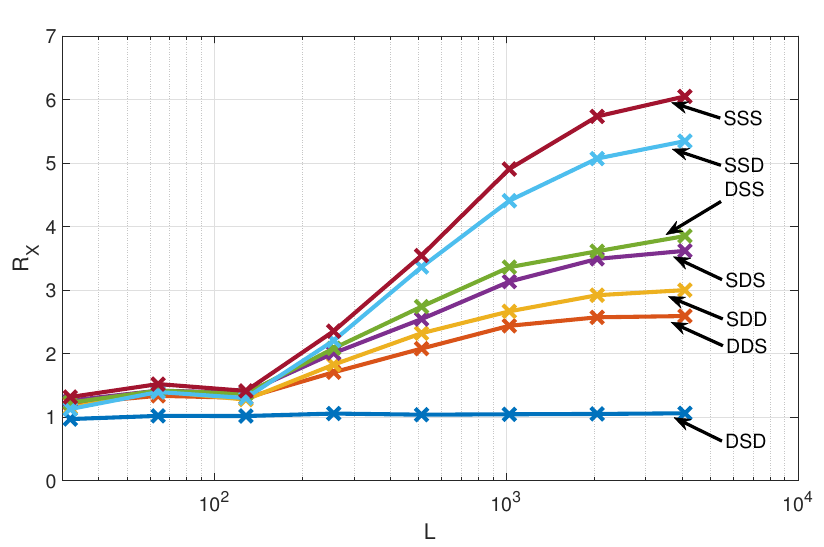
Figure 1. Relative speedups R X of various degrees of mixed precision X and full single precision (SSS) compared to full double precision (DDD) for various linear grid sizes from L = 36 to L =